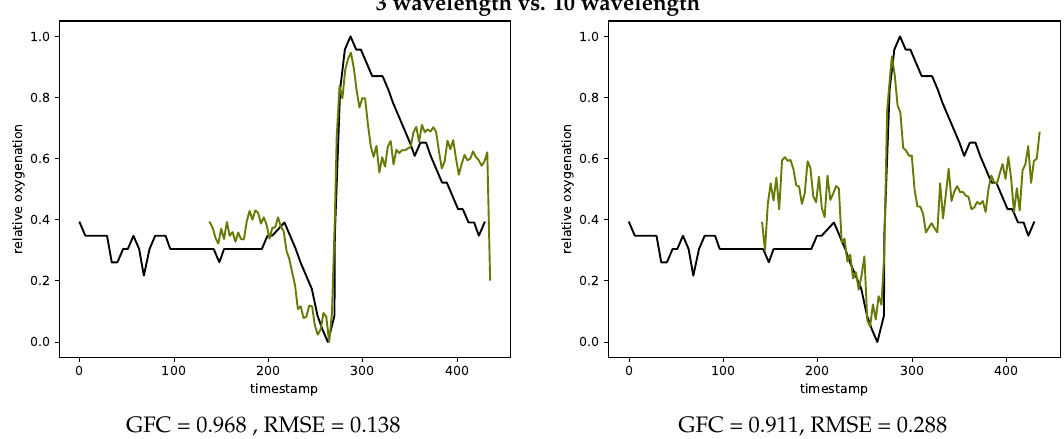
Figure 14. Oxygenation curves calculated with the three chosen wavelength ( left , #V27-2) and using all wavelength ( right , #V27-2) in comparison with the INVOS measurements